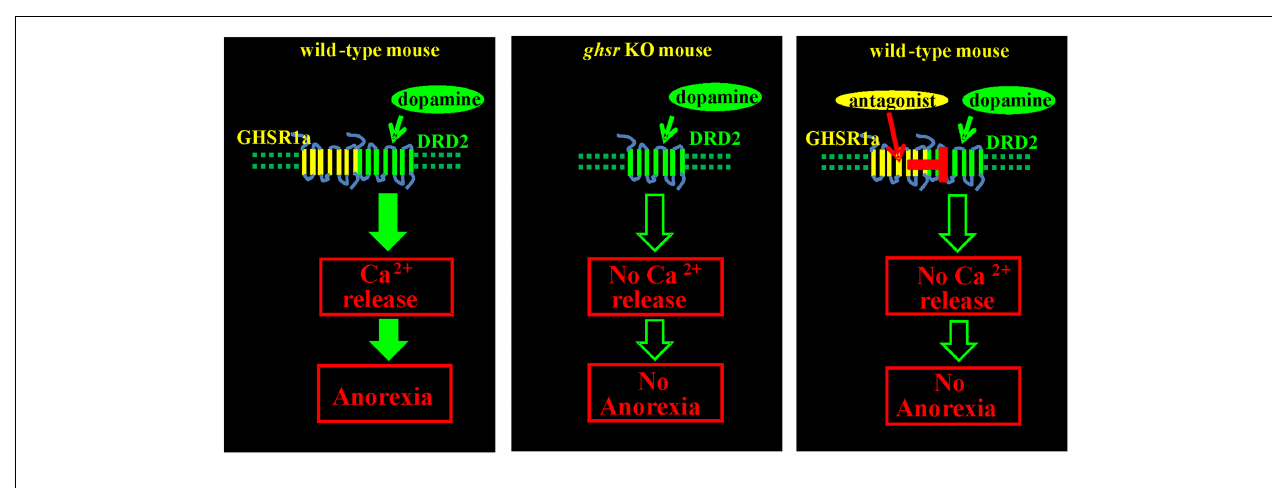
antagonist, JMV2959, are refractory to the anorexigenic effects of cabergoline; hence, inhibition of food intake by cabergoline is dependent upon allosteric interactions between GHSR1a and